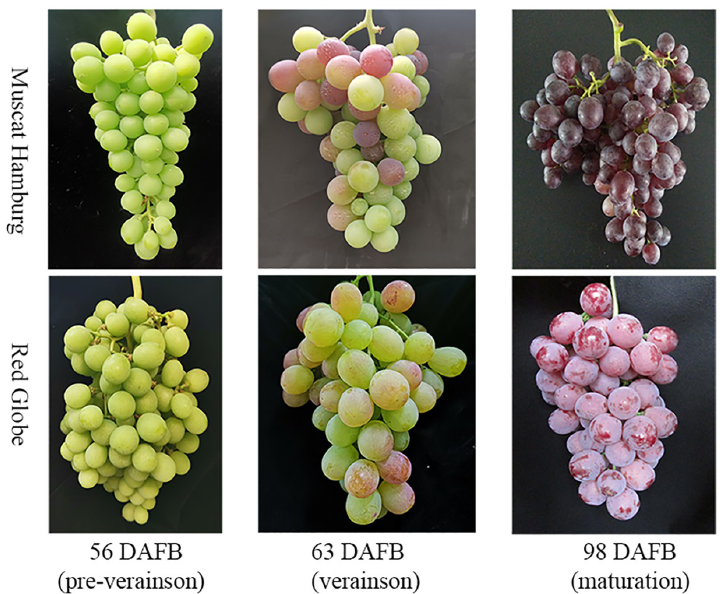
Fig 1. Images showing cluster-level changes in berries of ‘Red Globe’ and ‘Muscat Hamburg’ at the preveraison, veraison and maturation